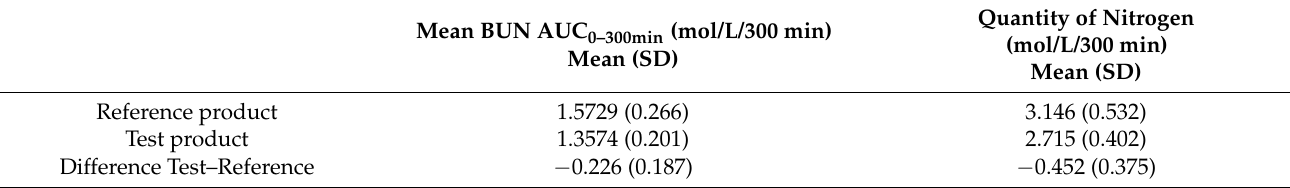
Table 5. Comparison of total nitrogen present as BUN AUC 0–300 after the Test and Reference